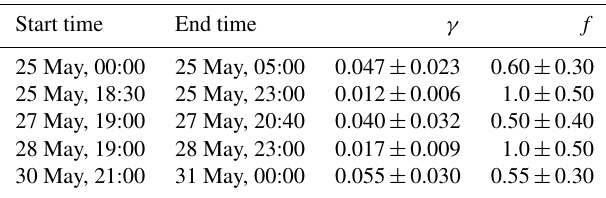
Table 4. List of the N 2 O 5 uptake coefficients and the yield of ClNO 2 in this campaign.